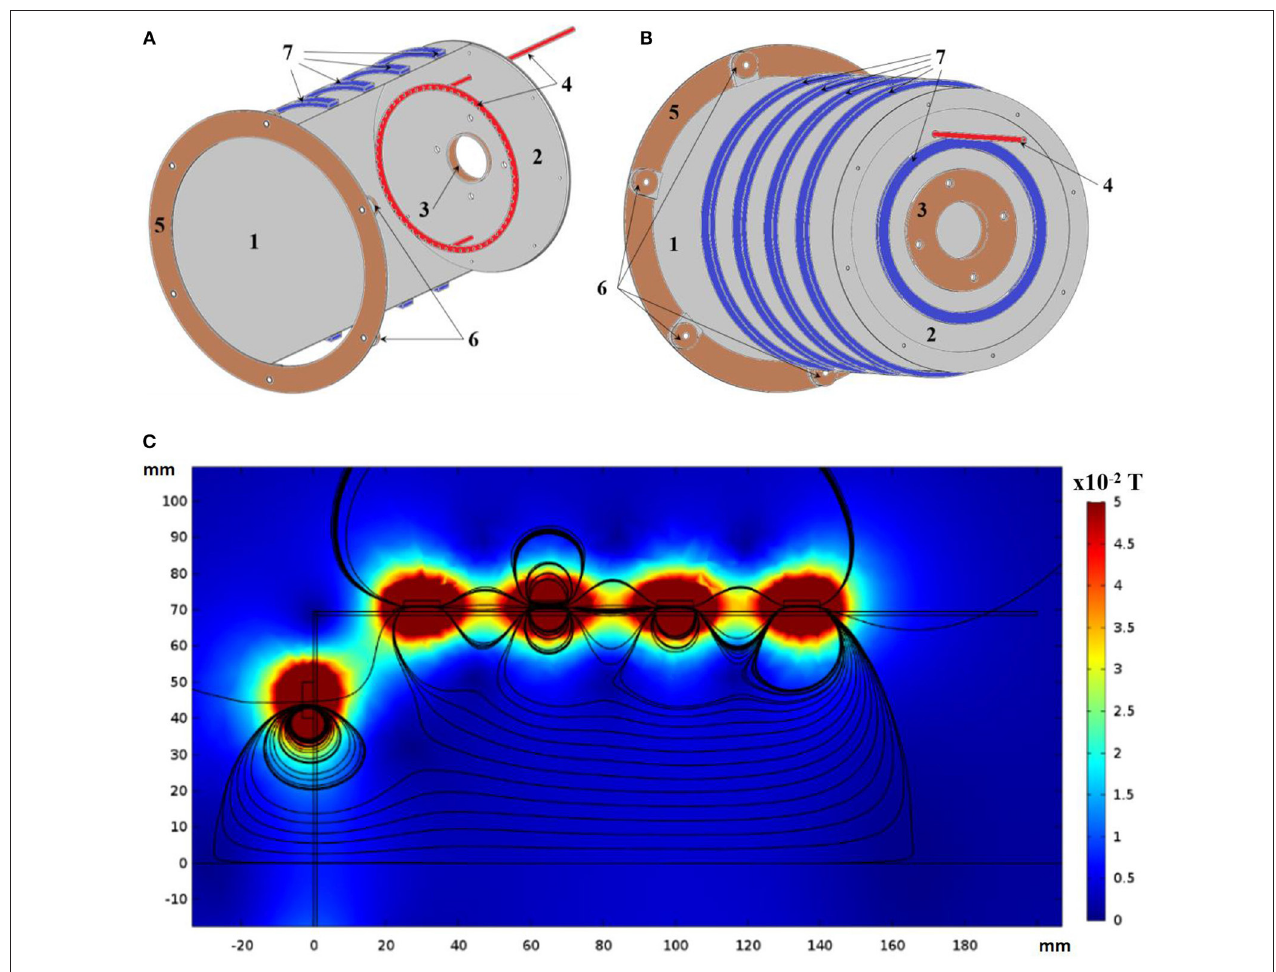
FIGURE 9 | Discharge chamber (A) front open isometric view, (B) rear view, and (C) magnetic